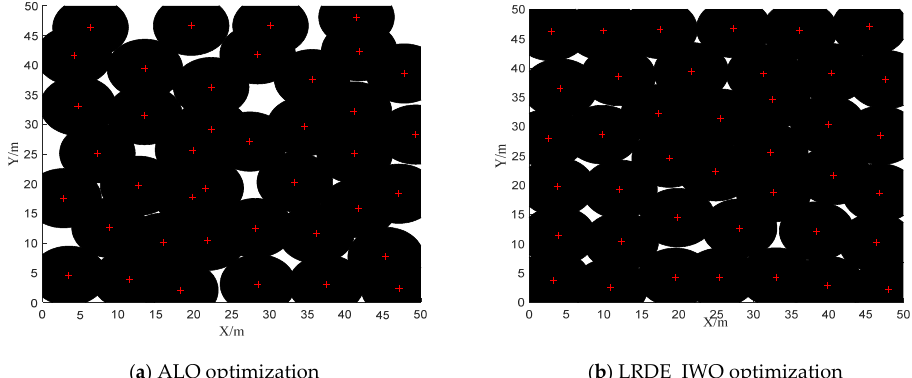
Figure 7. Node distribution optimized by ALO and LRDE_IWO. Table 5. Comparison of the optimized coverage results between ALO and LRDE_IWO.